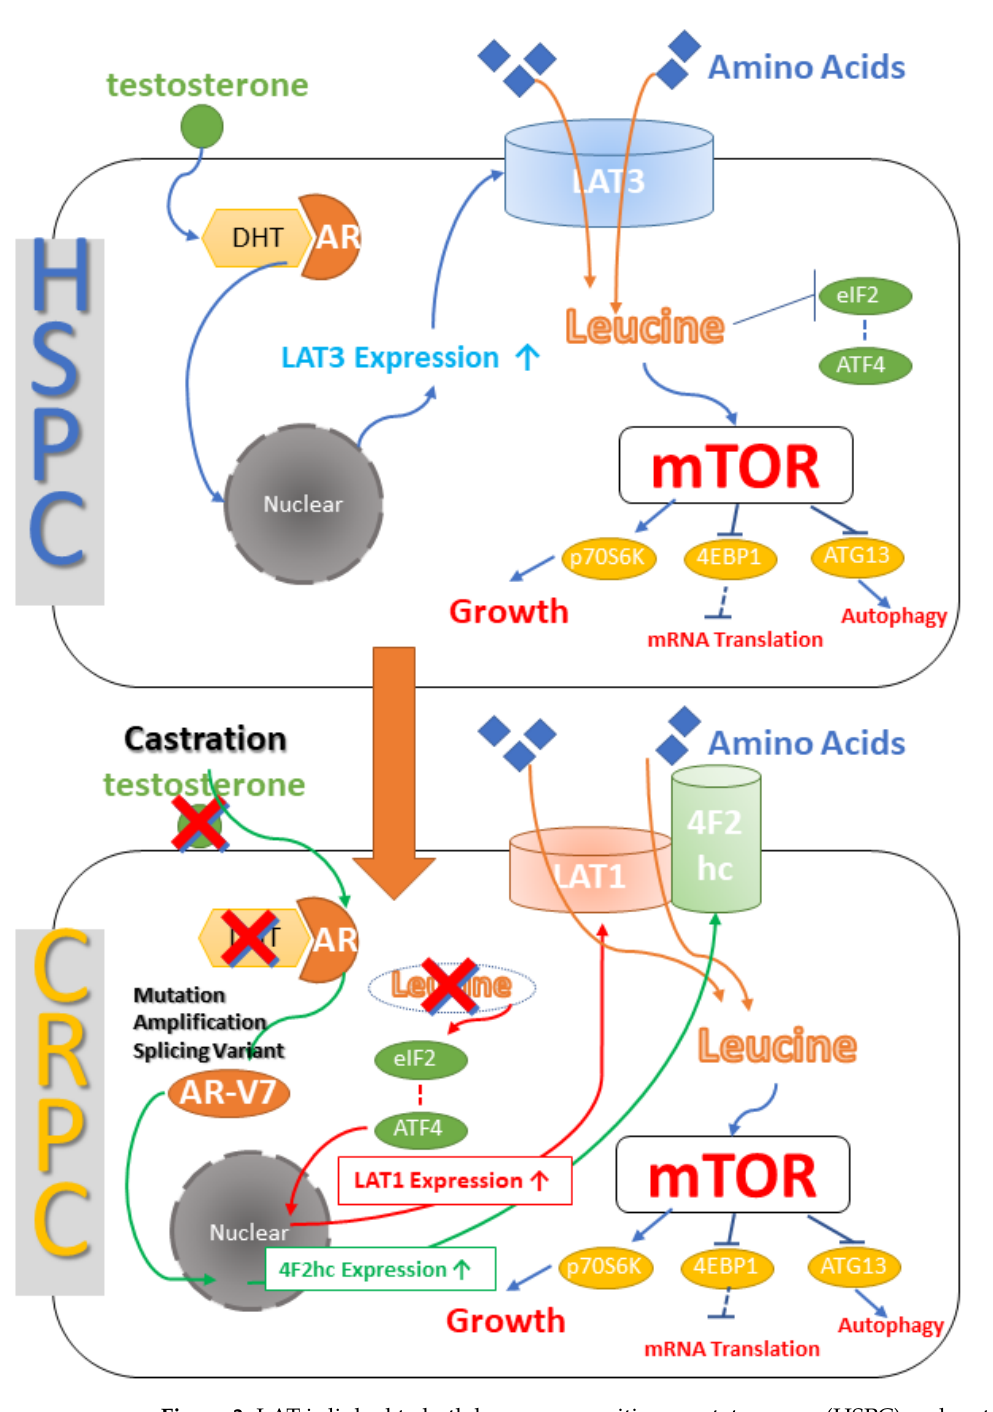
Figure 3. LAT is linked to both hormone-sensitive prostate cancer (HSPC) and castration-resistant prostate cancer (CRPC). In untreated HSPC, 5-alpha reductase converts testosterone to dihydrotestosterone (DHT), which binds to the androgen receptor (AR), enters the nucleus, and stimulates LAT3 transcription, resulting in enhanced LAT3 expression and contributes to the mTOR pathway activation. When hormone therapy is used to treat PCa, testosterone levels fall, resulting in castration, and ARs that no longer bind DHT change, increase, and generate splicing variants. AR-V7, in particular, can enter the nucleus in the absence of testosterone activation, and 4F2hc is present in its downstream signaling. Furthermore, the removal of leucine from the cells results in the lack of eIF2 repression and the admission of ATF4 into the nucleus. It enhances LAT1 expression, and LAT1 and 4F2hc form a dimer, allowing leucine into the cell and promoting tumor cell proliferation